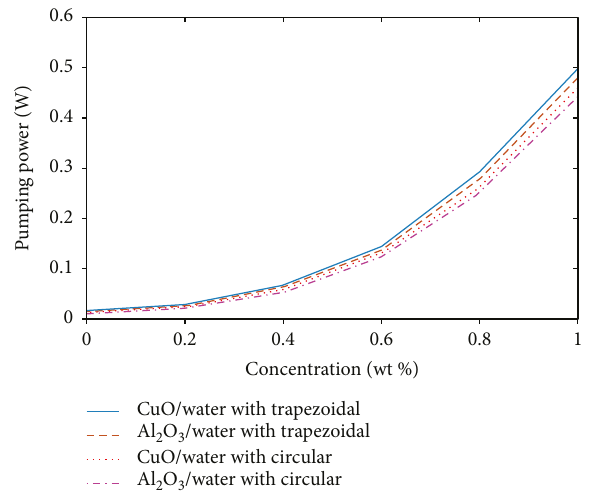
O /water and CuO/water with di ff erent concentrations. 2 3